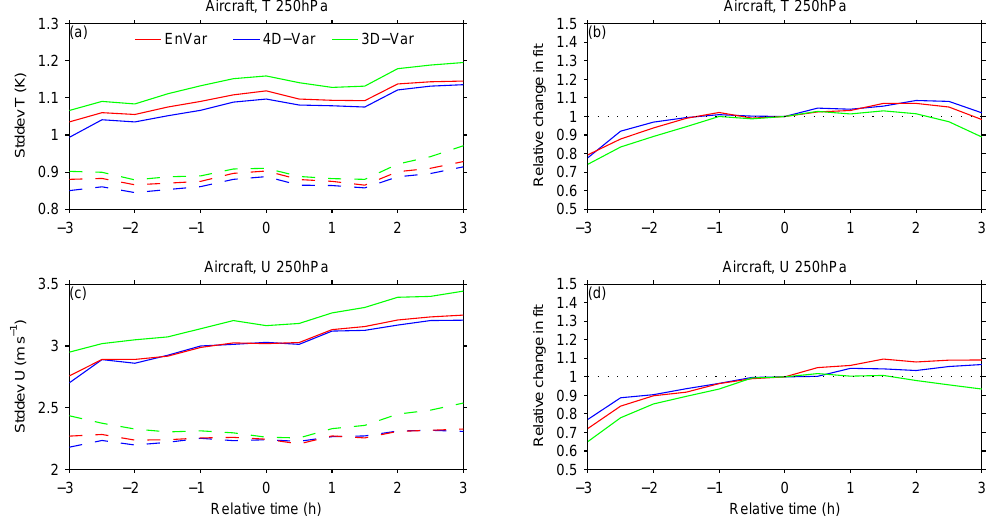
Fig. 12. Results showing the mean fit of the analyses from different assimilation approaches over the 6h assimilation window. Left pan- els: the standard deviation of the observation-minus-background (solid curves) and observation-minus-analysis (dashed curves) for aircraft observations. Right panels: the relative improvement in the fit to the observations made by the assimilation procedure, normalized by this measure at the middle of the assimilation window (see Eqs. 4 and 5). These are shown for all observations of 250hPa temperature (upper panels) and 250hPa zonal wind (lower panels) from aircraft over the February/March 2011 period for the EnVar (red), 4D-Var (blue), and 3D-Var (green) experiments. The 4D-Var results are from propagating the analysis increment with the tangent linear